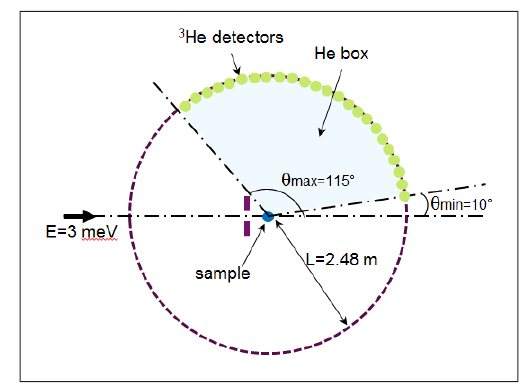
Figure 1. (Color online) Simplified top view of the IN6 time-of- flight spectrometer of the Intitute Laue-Langevin (ILL).